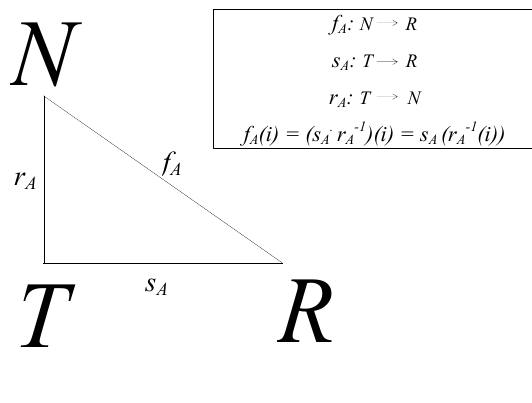
Figure 5. Rank-Score Characteristics (RSC)